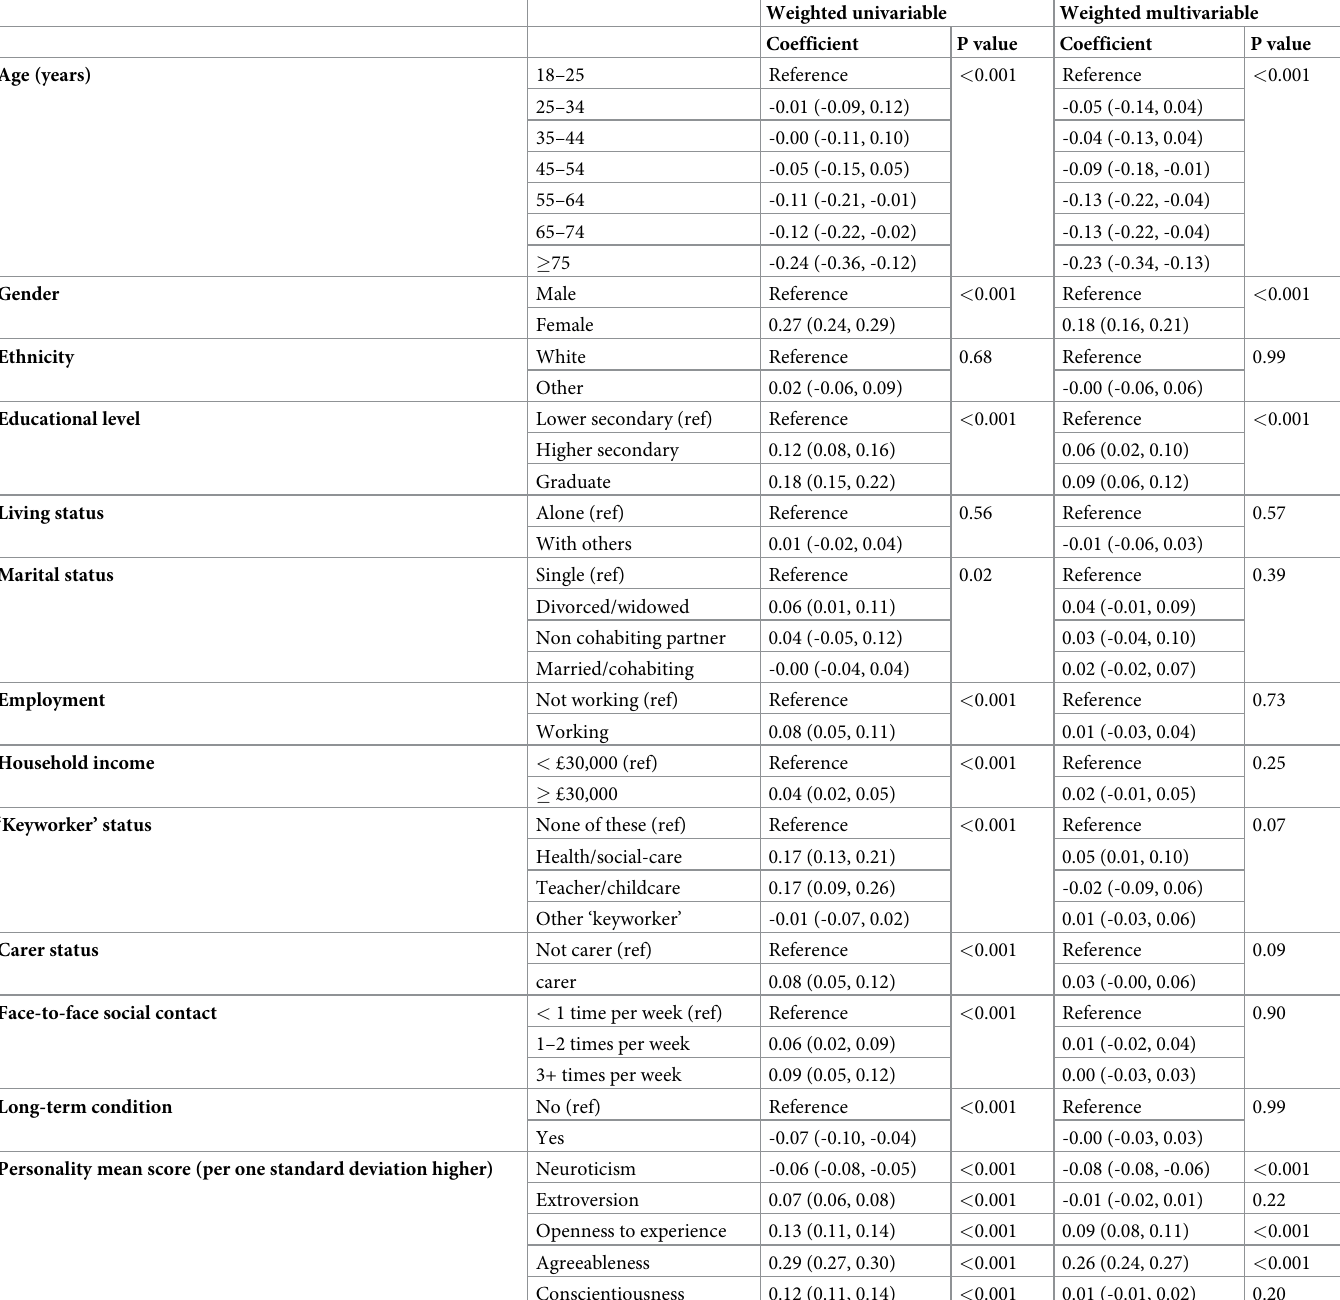
Table 4. Association of participant characteristics with perspective taking (n =